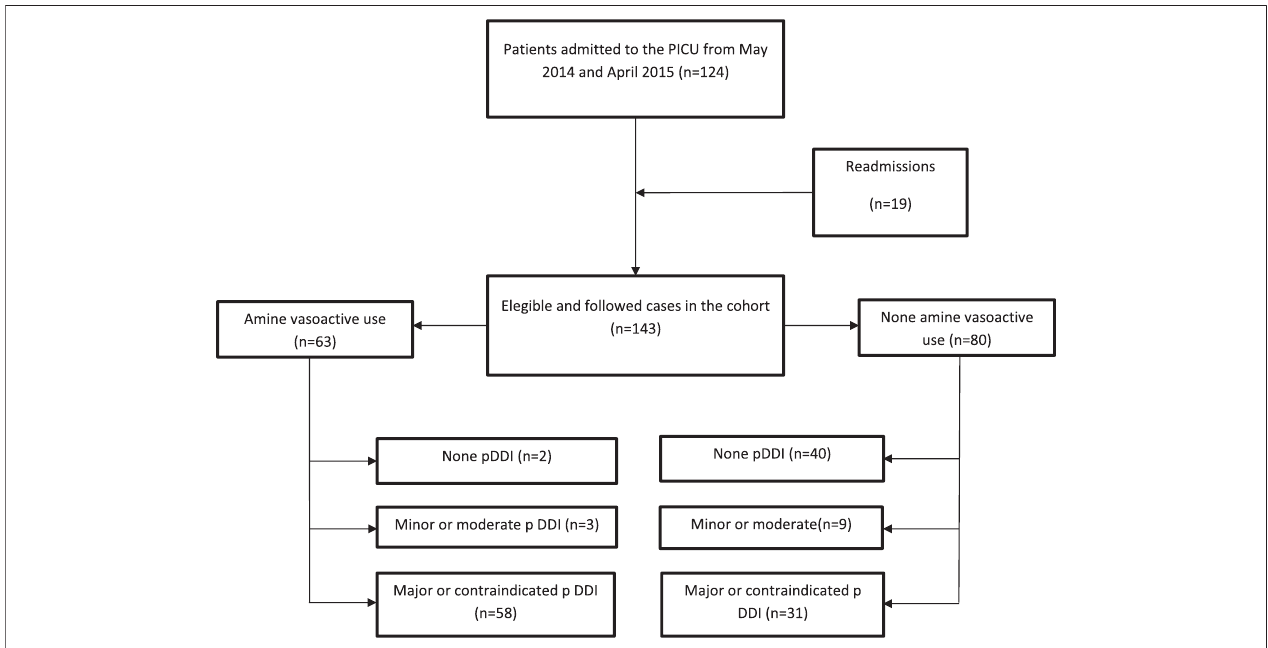
FIGURE 1 | Flow chart of followed cases in the cohort study (May 2014 – April